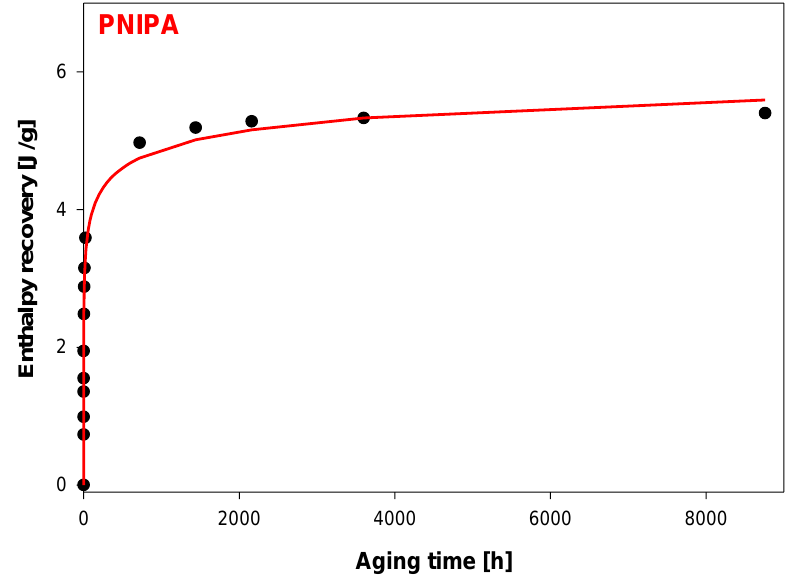
Figure 7. Enthalpy recovery vs. aging time at T a = 400.15 K for the amorphous PNIPA. The solid line is the result of fit the experimental data to Kohlrausch–Williams–Watts (KWW) function (R 2 = 0.9894).